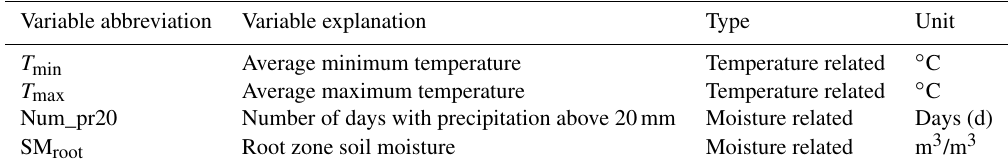
Figure 1. Average total production in tonnes over the period of study (1982–2016). Counties with 35 years of data are highlighted with a thin black perimeter. Grey regions represent filtered out counties where local agriculture is less than 90% rainfed. Table 1. Climate variables calculated at seasonal and monthly timescales throughout the growing